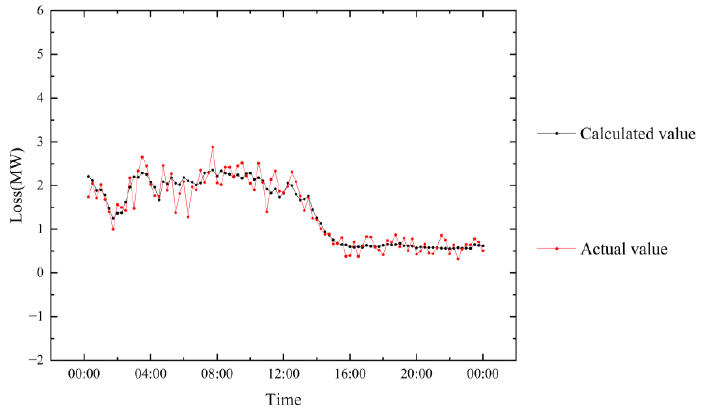
Figure 9. Calculation of cable loss results based on wind turbine power. Figure 10. Calculation of cable loss results based on the power of the collector system. Table 1. Error comparison of submarine cable loss calculation results.